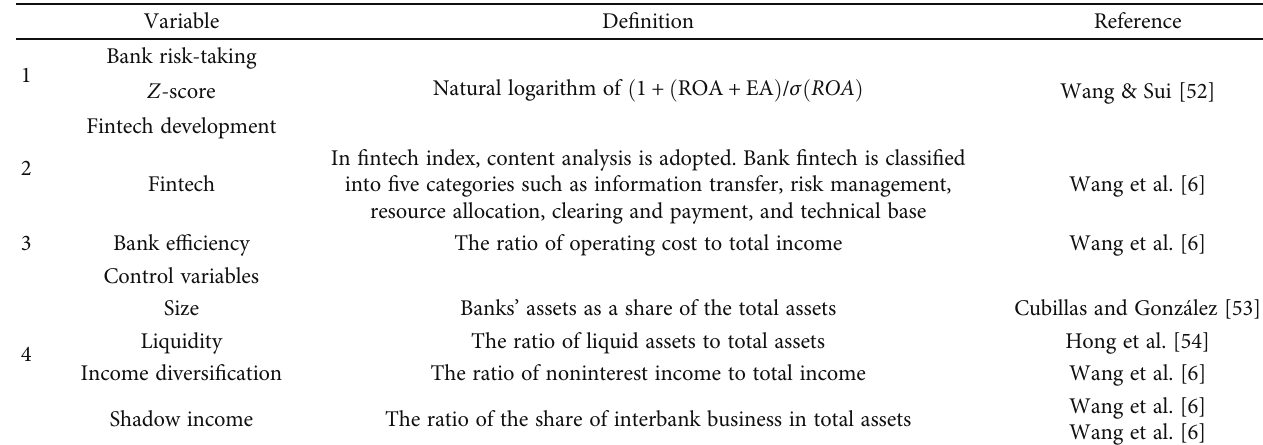
Table 2: Measurement of variables.